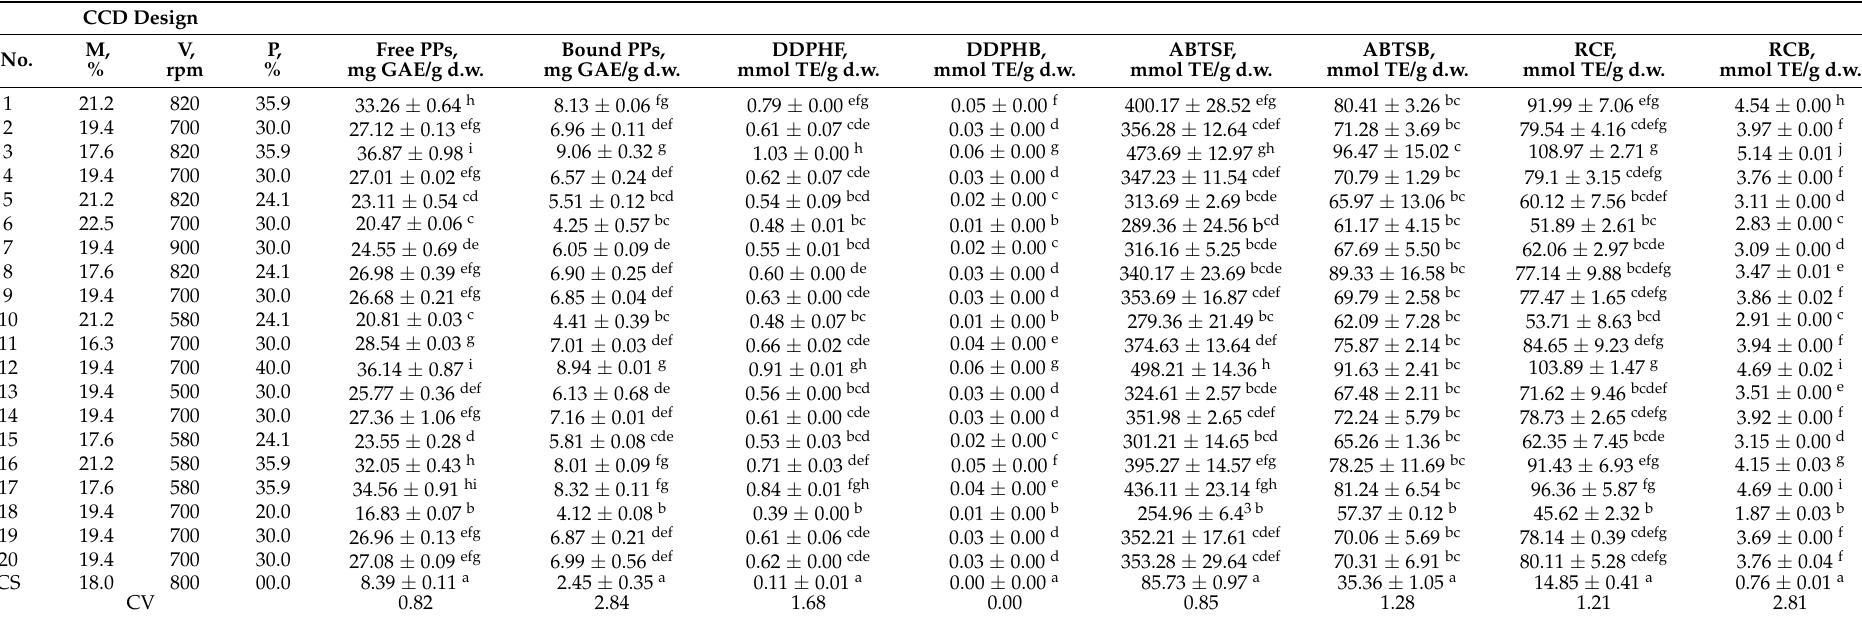
Table 2. Contents of free (Free PPs) and bound (Bound PPs) (poly) phenolics (PPs), and the antioxidant capacity tests for both free and bound (polyphenolics) by the DPPH and ABTS methods. Total reducing capacity (RC) test for free (RCF) and bound phenolics (RCB) for extrudates and the control